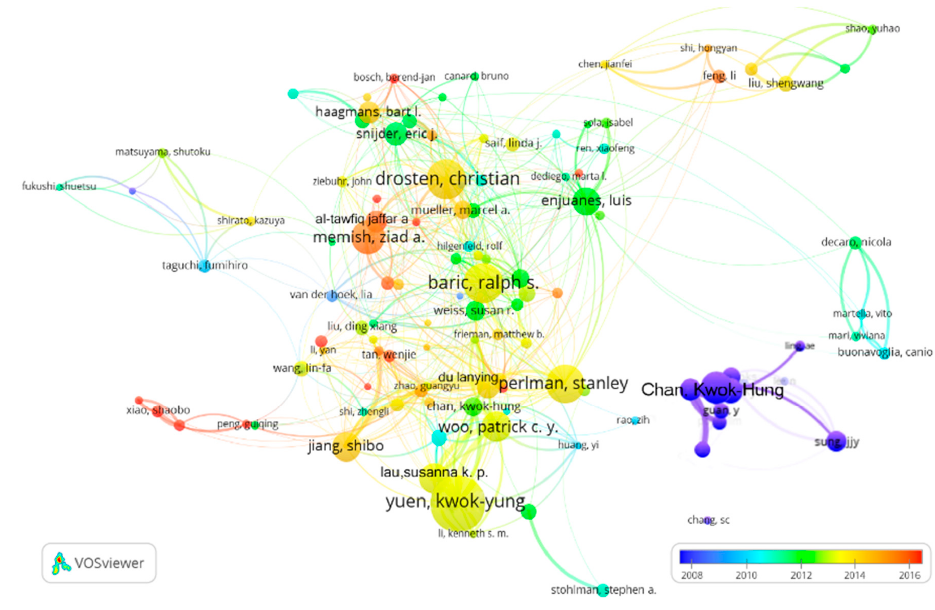
Figure 3. Co-authorship network of authors. Table 1. Top 10 authors in coronavirus research.